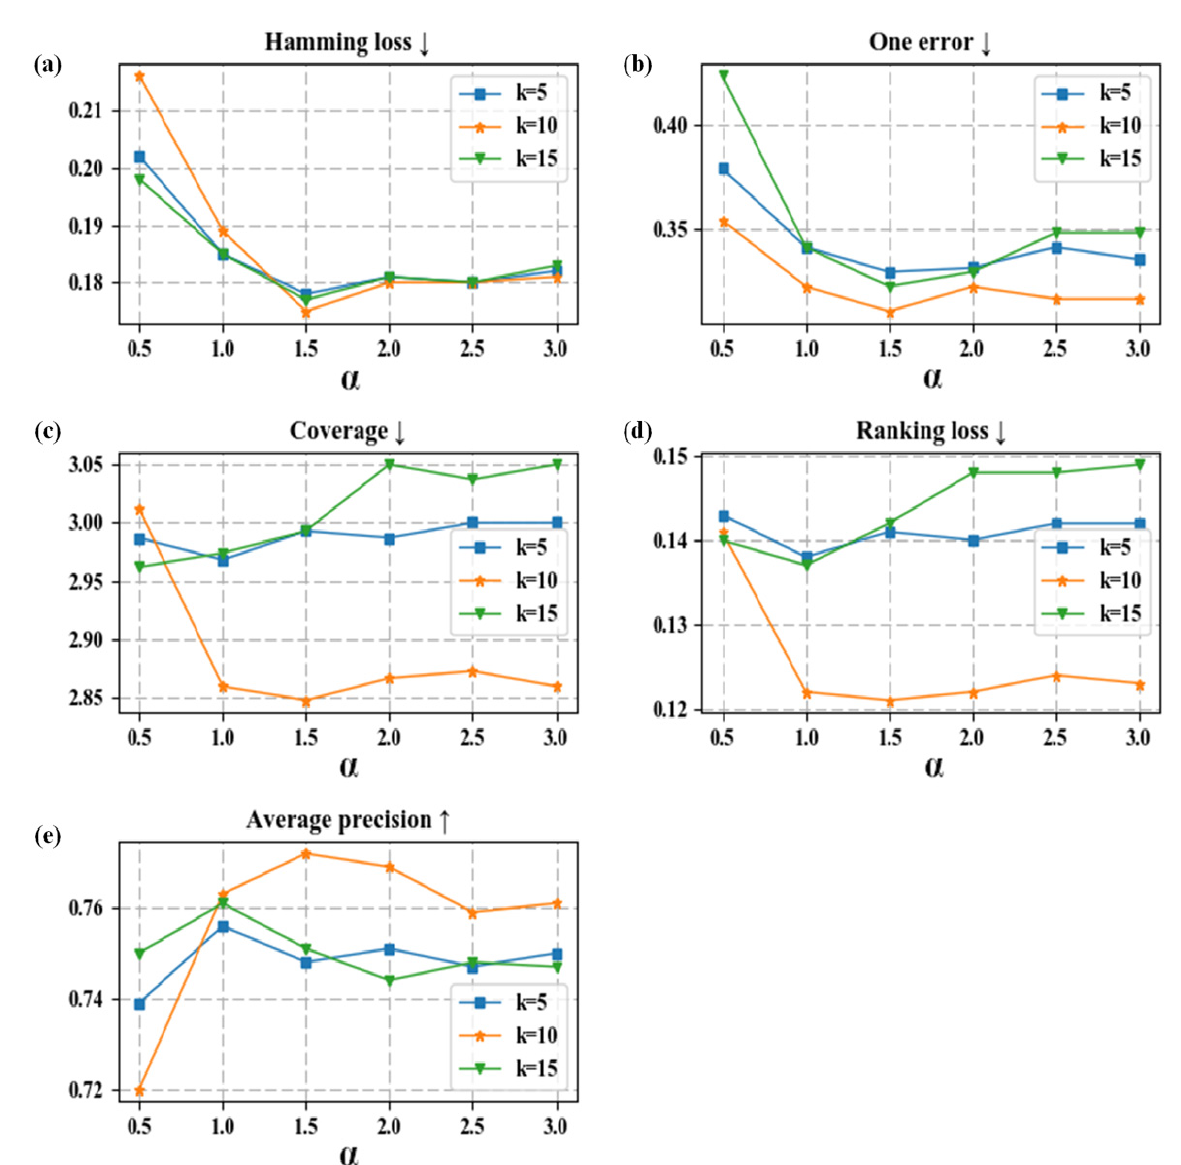
Figure 5. I-MLKNN results of different parameters. ( a ) Hamming loss; ( b ) One-error; ( c ) Coverage; ( d ) Ranking loss; ( e ) Average precision.